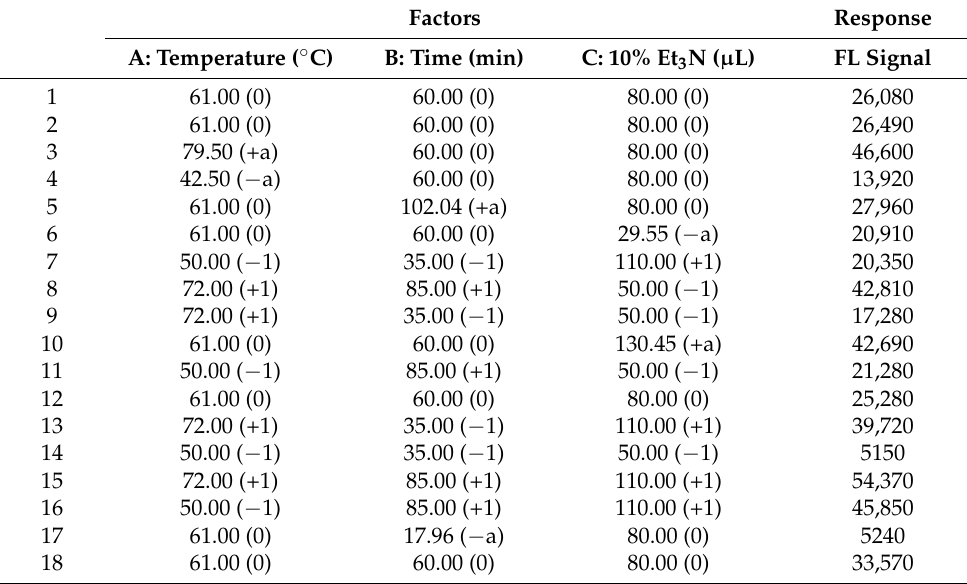
Table 1. Plan of experiments for CCD and experimentally obtained responses. Coded values for factors are presented in parentheses. Factors Response